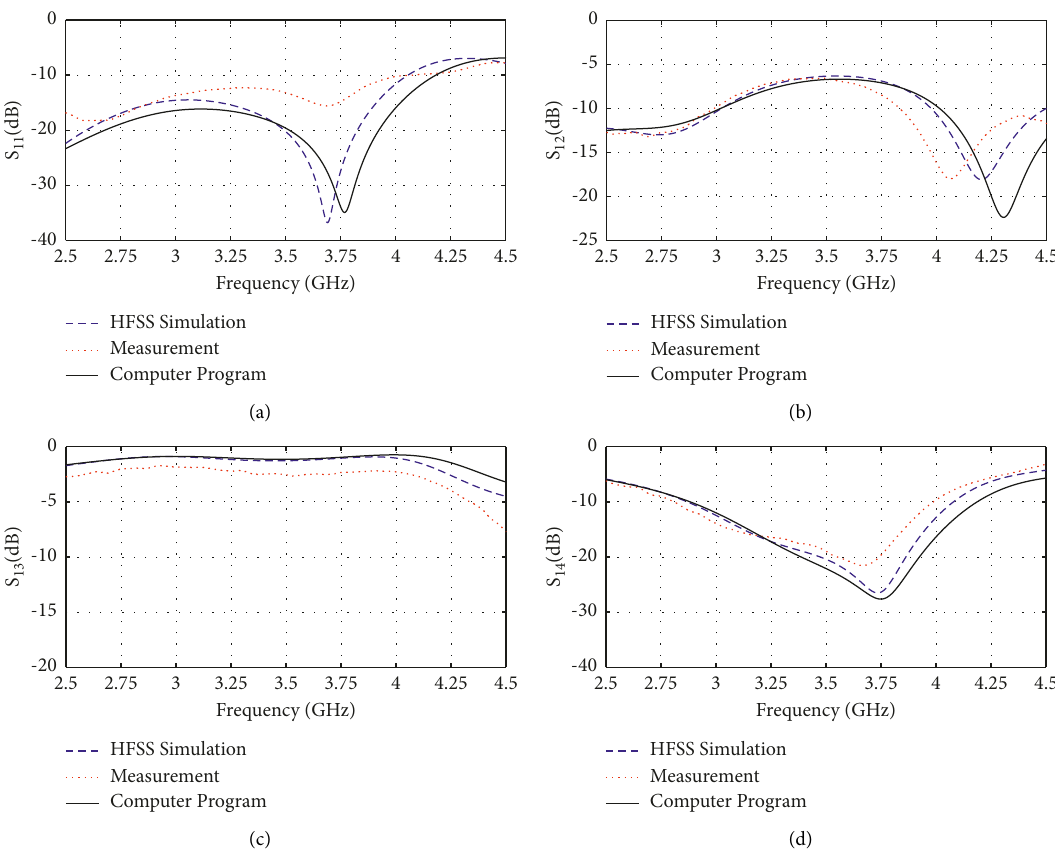
Figure 13: Frequency response of 6dB ATRD coupler. (a) Reflection Loss; (b) Coupling coefficient; (c) Through coefficient; (d) Isolation Coefficient.